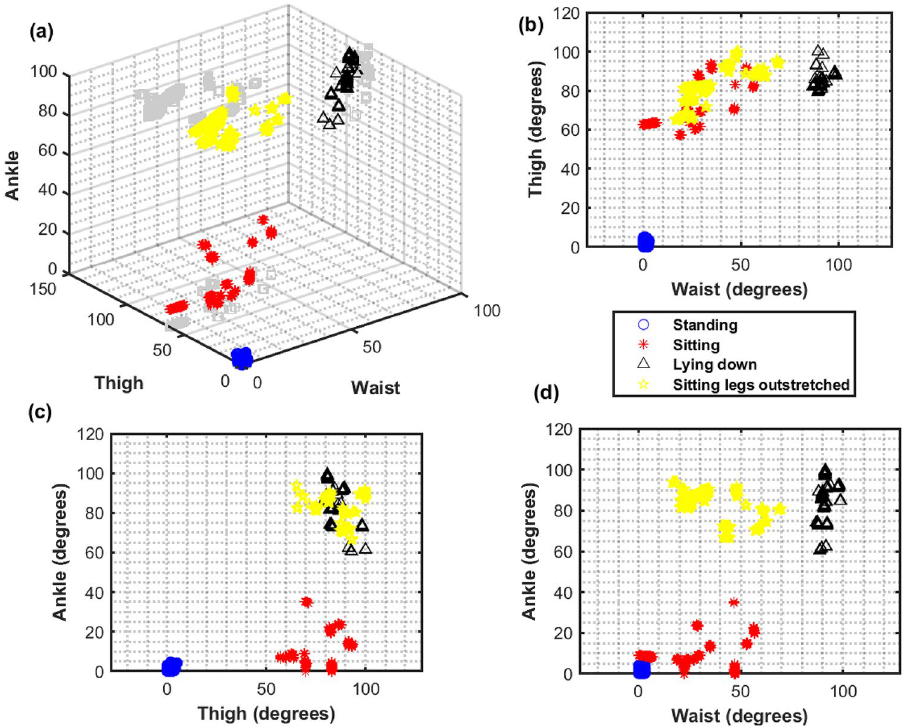
Figure 5. ( a ) 3D plot of the inclination angles. Shadows of the data are projected in grey onto the walls of the graph. Four clusters correspond to standing (blue ‘o’), sitting (red ‘x’), lying down (black ‘ △ ’) and sitting with legs outstretched (yellow pentagon). Projections of the data are shown in ( b ) ‘thigh’ vs ‘waist’, ( c ) ‘ankle’ vs ‘thigh’ and ( d ) ‘ankle’ vs ‘waist’.